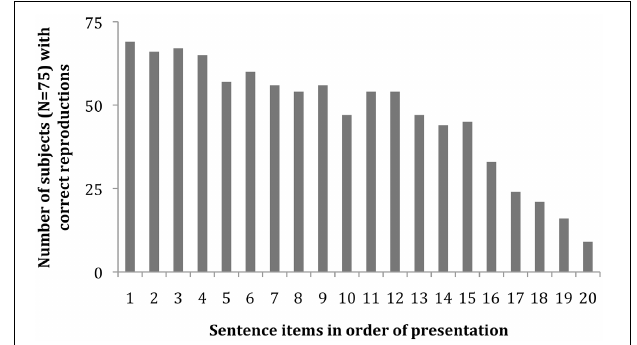
FIGURE 2 | Number of participants per group (maximum N = 25) with correct sentence reproduction as a function of sentence complexity ordered from easiest (sentence 1) to hardest (sentence 20).